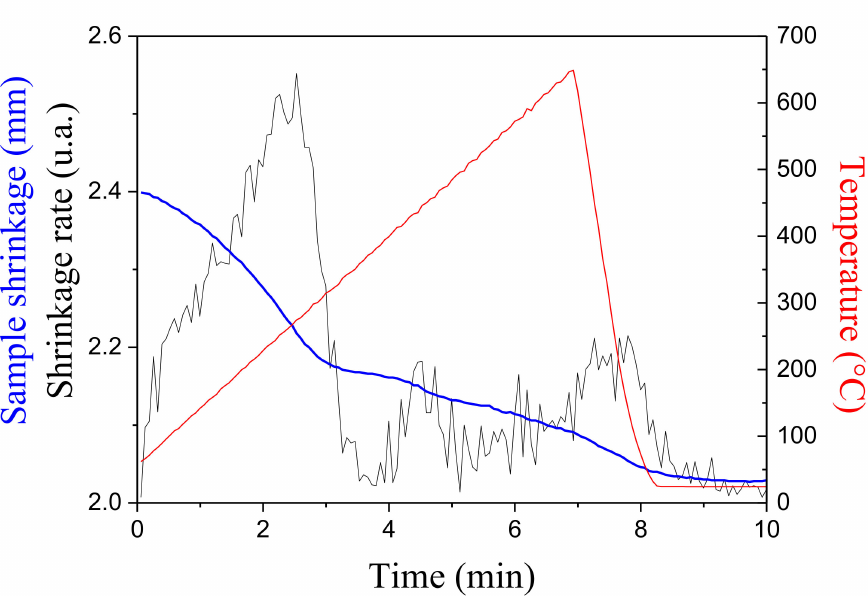
Figure 15. Sintering curve of an anatase-TiO 2 nanopowder recorded under 1 GPa upon heating up to 650 ◦ C.